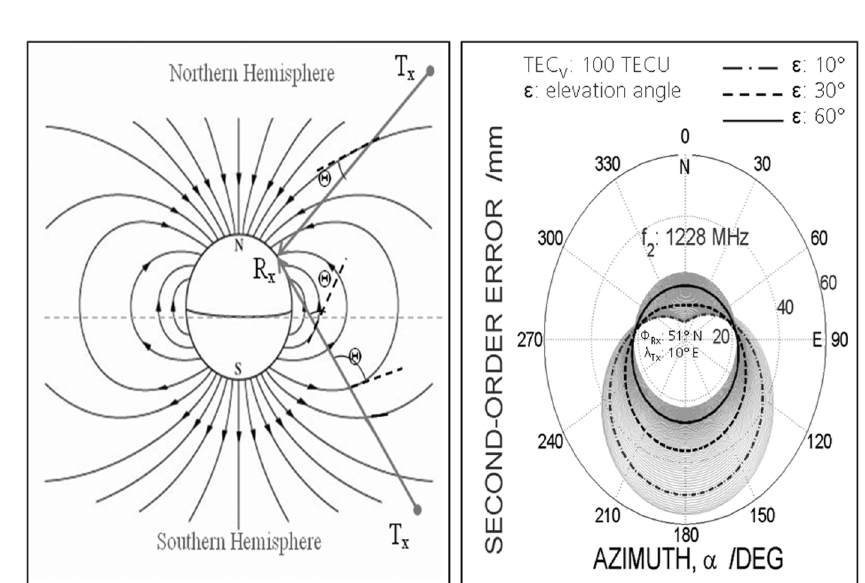
Fig. 5. Left panel: Illustration of the effect of the ray path-magnetic field geometry causing an asymmetry in the refraction. Right panel: Second order ionospheric range error (radial distance from 0-60 mm) for the GPS L 2 frequency assuming a vertical TEC of 100 × 10 16 electrons/m 2 for a mid-European station as a function of az- imuth at different elevation